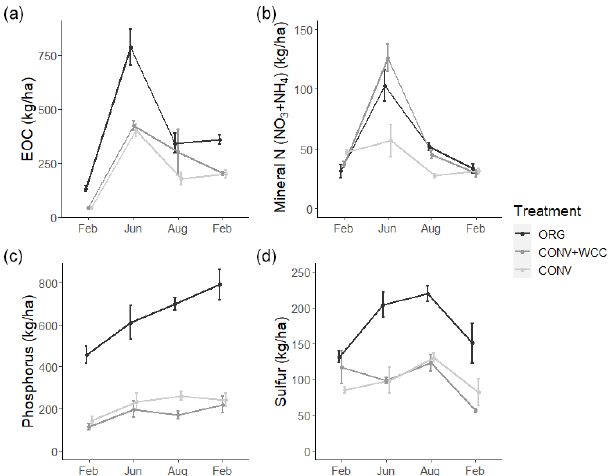
Figure 7. (a–d) Extractable organic C, mineral N, phosphorus, and − + NH + ), sulfur stocks at 60–100cm in ORG, CONV + WCC, and CONV sys- 3 4 tems over the February 2018–February 2019 season. All values are given in kilogram per hectare. Error bars represent standard